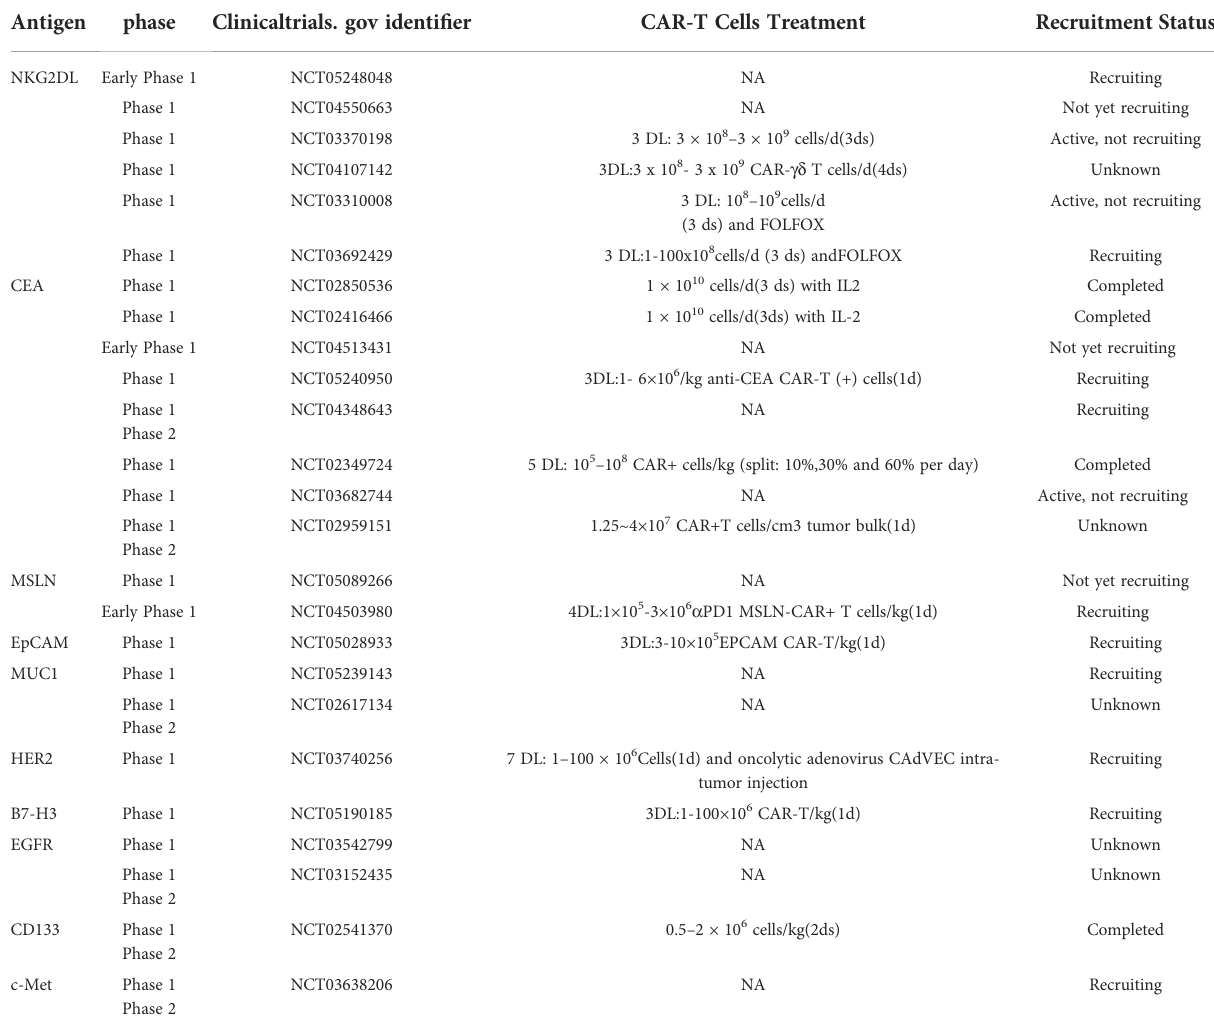
TABLE 1 Clinical trial of CAR-T cells in CRC(https://clinicaltrials.gov/).